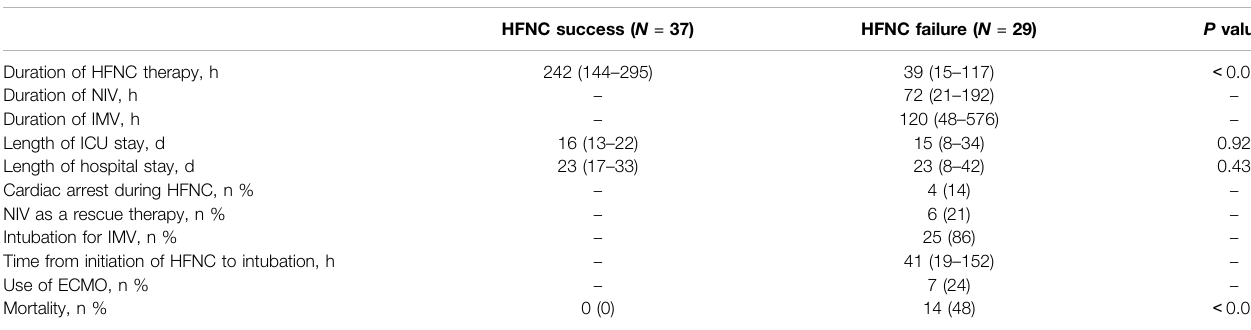
TABLE 3 | Outcomes of patients with HFNC success and